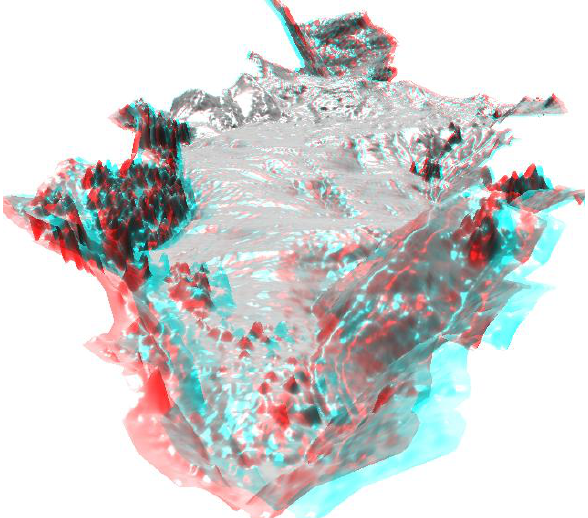
Figure 12. Virtual 3D anaglyph of the Super-Sauze landslide (red/cyan glasses are required for full 3D